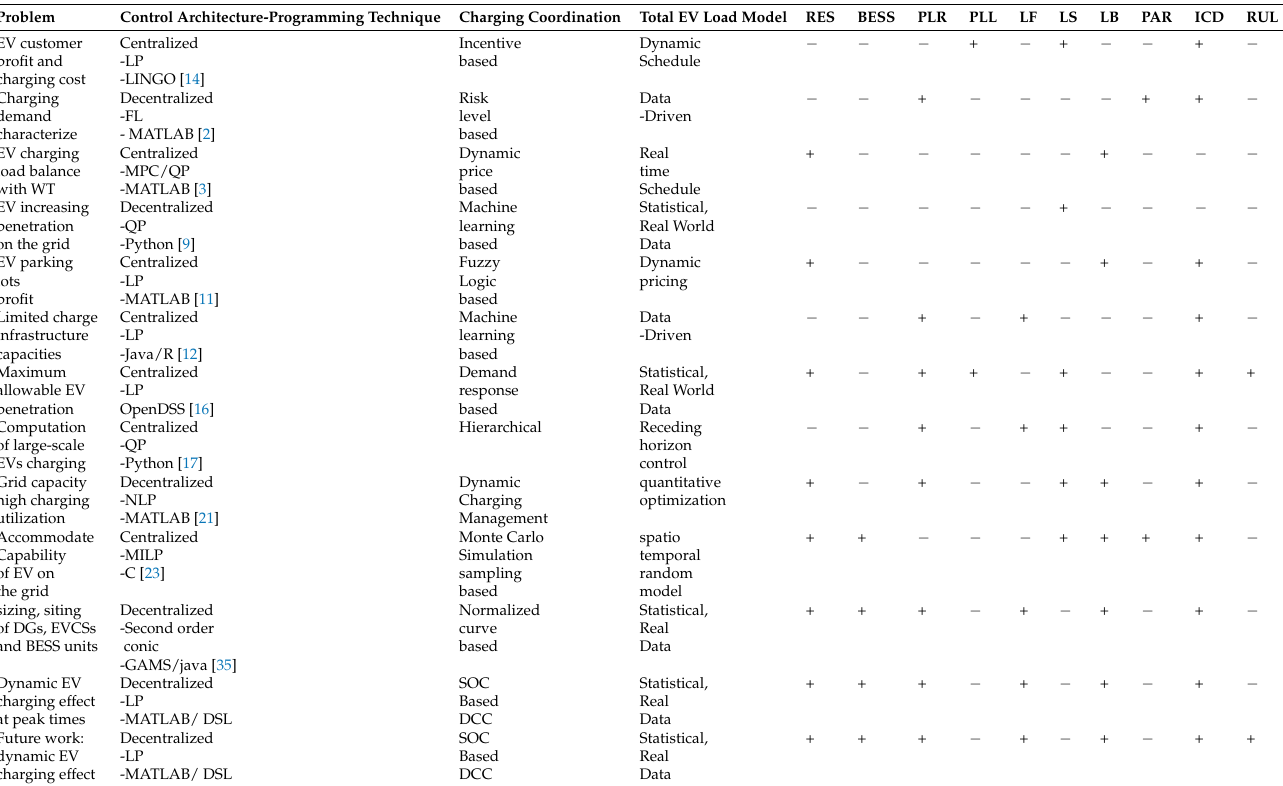
Table 3. Comparison of charging coordination approaches for grid integration of